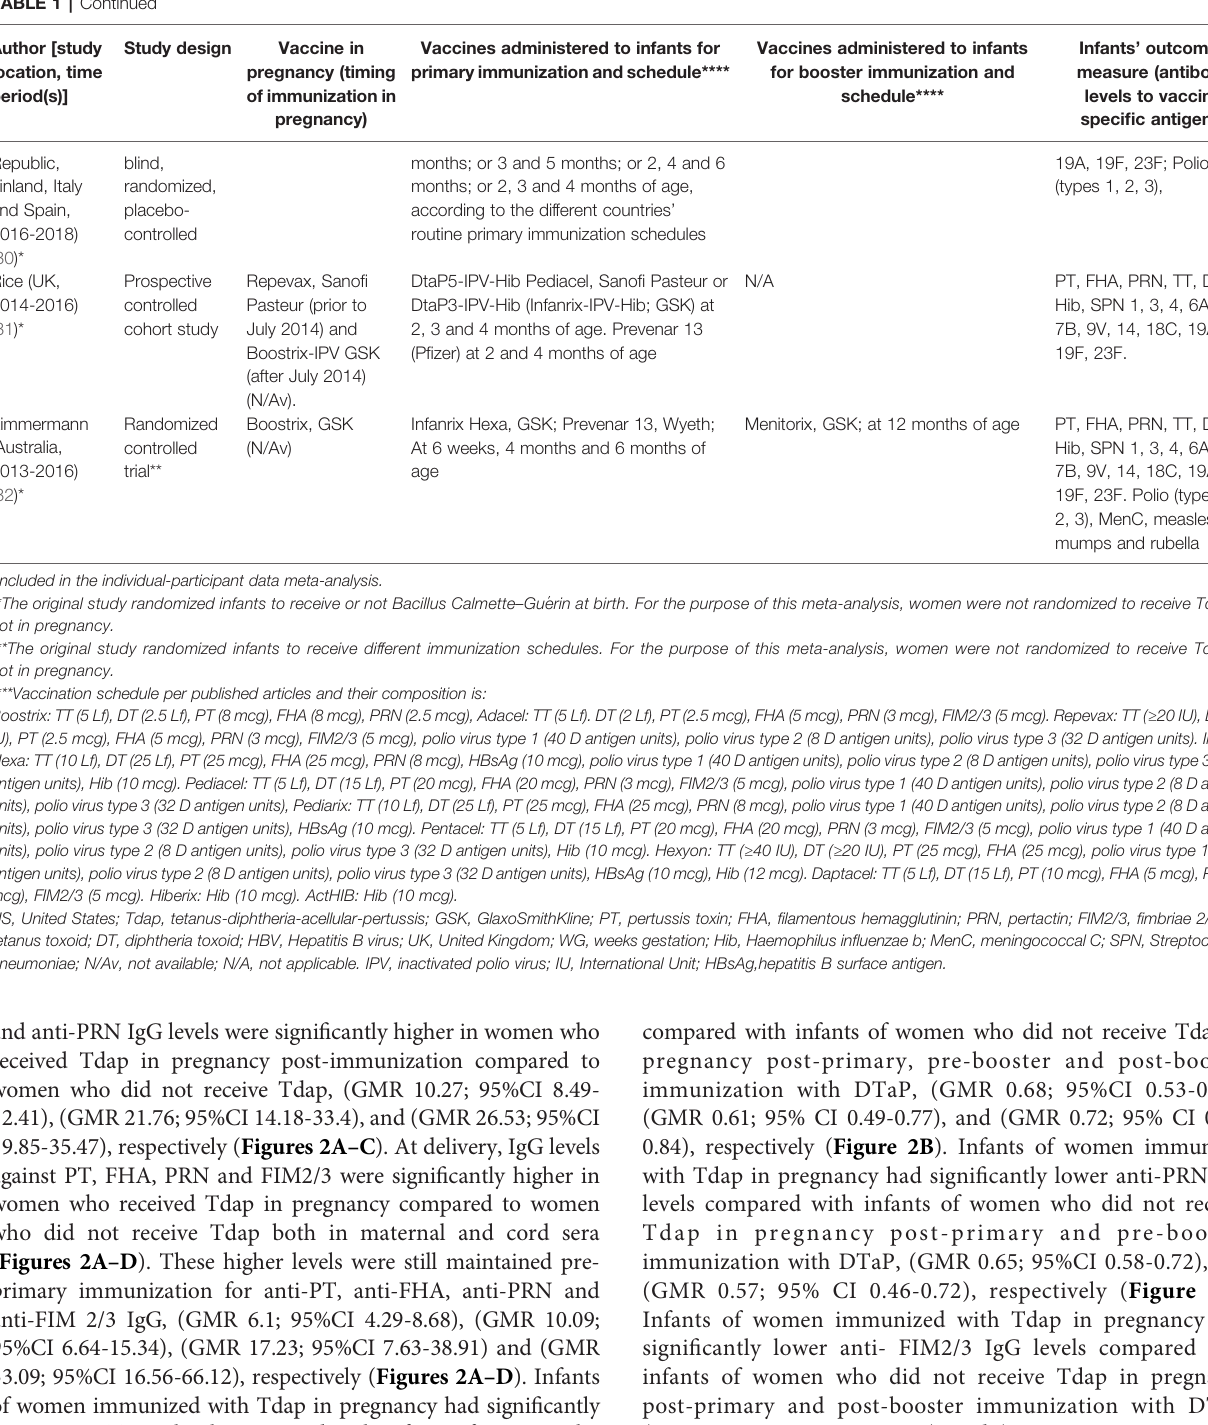
Infants of women immunized with Tdap in pregnancy had signi fi cantly lower anti- FIM2/3 IgG levels compared with infants of women who did not receive Tdap in pregnancy post-primary and post-booster immunization with DTaP, 0.96), respectively ( Figure 2D ). The GMRs of IgG against PT, FHA and PRN pre- immunization in pregnancy and at delivery in women immunized in pregnancy vs. unimmunized women and their infants strati fi ed by type of vaccine administered in pregnancy (Adacel versus Boostrix) were also computed ( Table 2